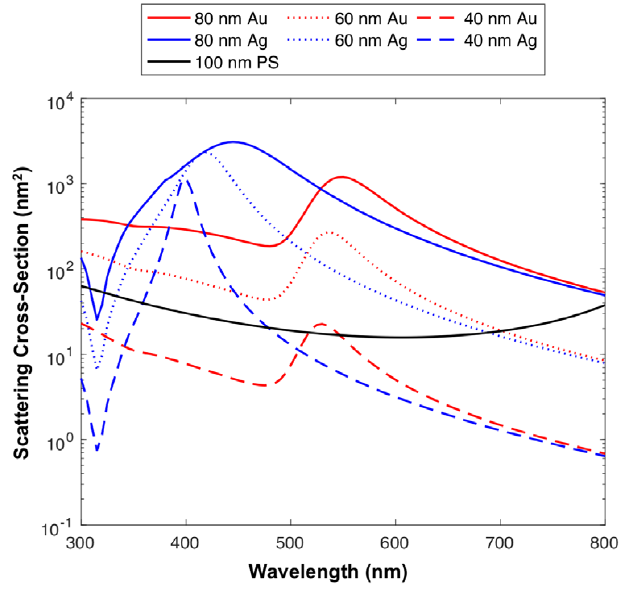
Figure 2. Modelled scattering cross-sections assuming Astrios EQ collection optics. Displayed are the scattering cross-sections of 40 nm, 60 nm, 80 nm Au (red) and Ag (blue) spheres and 100 nm polystyrene spheres (black).